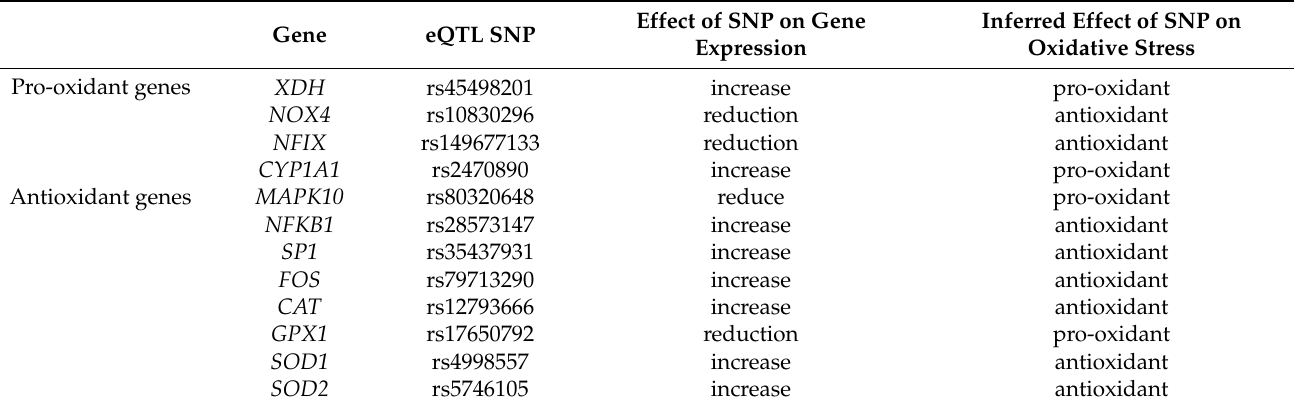
Table 1. Single-nucleotide polymorphisms (SNPs) used to create a genetic pathway function score for oxidative stress response (gPFS ox ). SNPs were identified using the GTEx database as expression quantitative trait loci (eQTLs) for genes within this